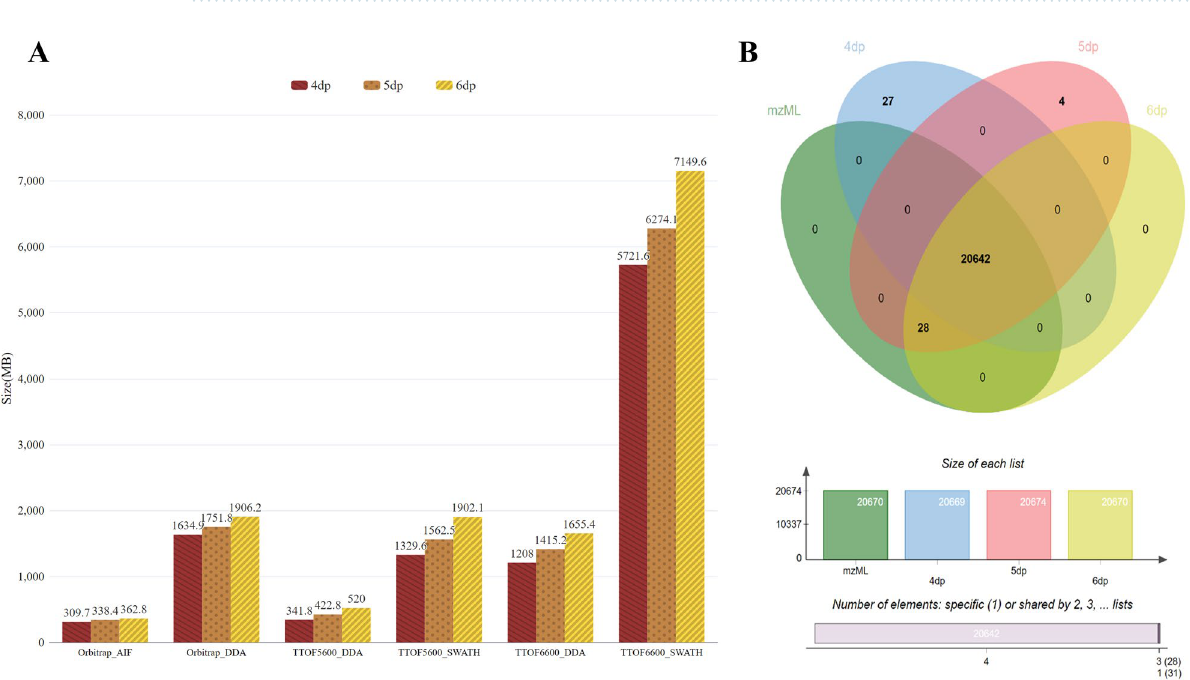
Figure 4. ( A ) Files with mz stored at 4, 5, and 6 decimal points size comparison. ( B ) Peak number comparison of mzML file and Aird (4, 5, 6 decimal points stored) files, after ADAP chromatogram building in MZmine3. Vendor file 13 is